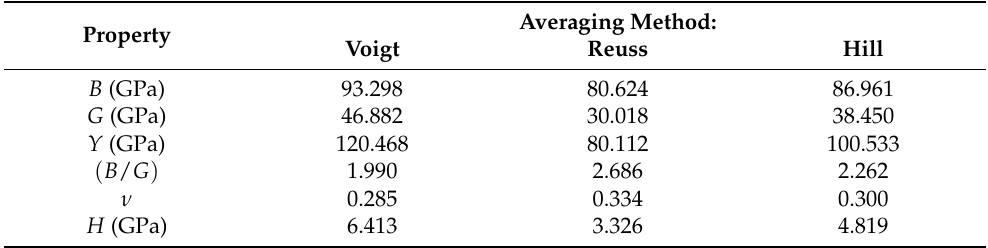
Table 6. Direction-averaged bulk modulus B , shear modulus G , Young’s modulus Y , Poisson’s ratio ν , bulk-to-shear modulus ratio ( B / G ) , and hardness H of α -Cu 2 P 2 O 7 calculated according to Voigt, Reuss, and Hill